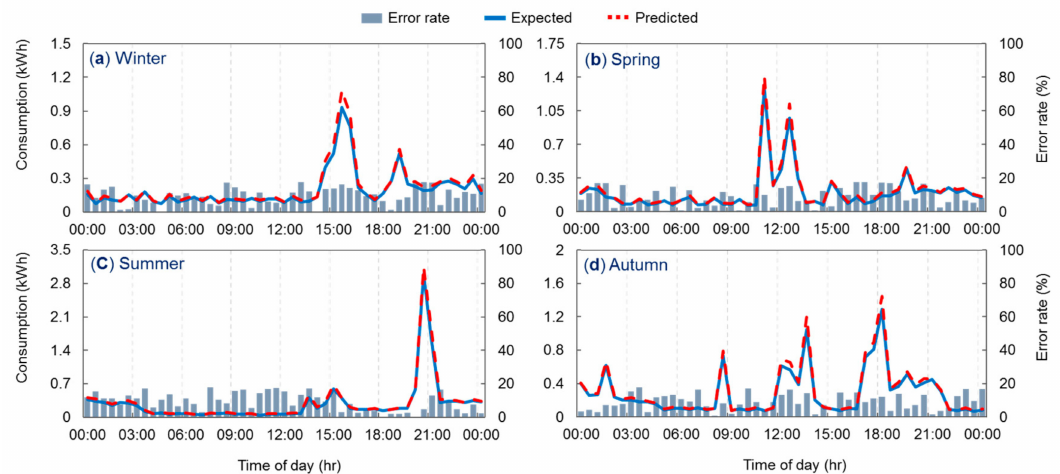
Figure 7. Comparison between the actual and predicted electricity consumption for the training results of ANN3 for a typical day in four seasons: ( a ) winter; ( b ) spring; ( c ) summer; and ( d ) autumn.